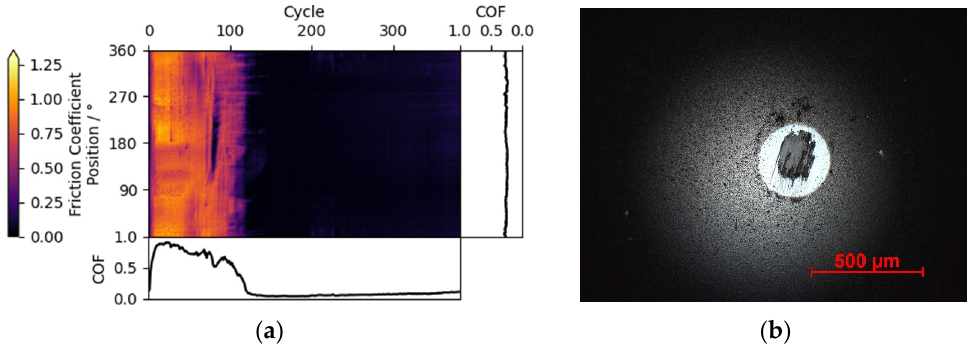
Figure 3. ( a ) Friction triboscopic image for an a-C coating against a ta-C 1 coated ball in 0.01 mbar vacuum, exhibiting GLOBAL features. ( b ) Micrograph of ta-C 1 counter body with worn-through coating and protective tribolayer (black inside white).